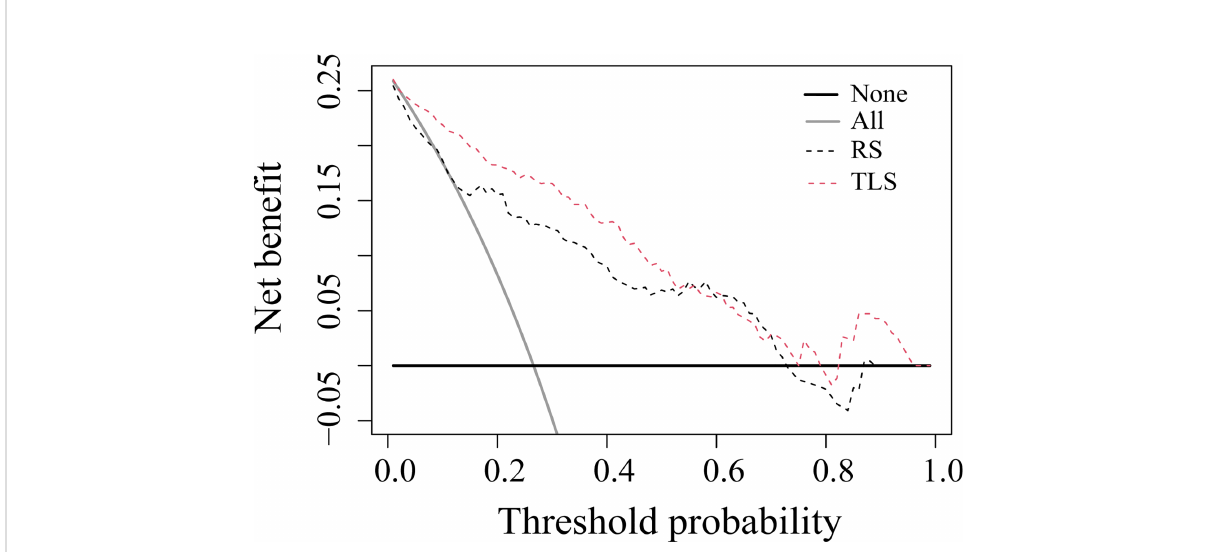
FIGURE 5 Decision curve analysis for prediction models. The solid gray line represents the assumption that all patients were involved in the LVI-positive group, while the black line represents the assumption that no patients were involved. The threshold probability was the point where the expected bene fi t of the treatment and treatment avoidance were equal. The results showed that the net bene fi t of the TLS was greater than that of the RS (range, 0.01 – 0.95). RS, radiomics signature; TLS, transfer learning